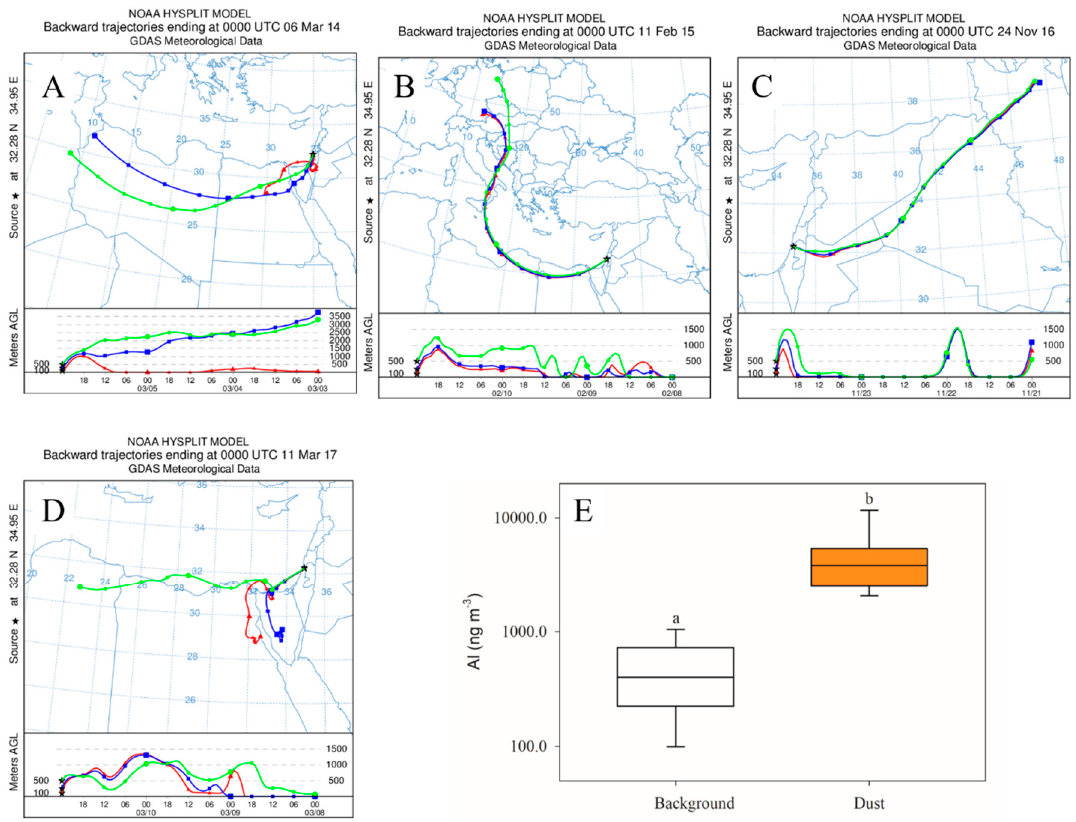
Figure 1. Back-trajectory analyses showing the main dust sources that arrived to the southeastern Mediterranean Sea (SEMS) from 2013 to 2017: ( A ) Sahara Desert, ( B ) Eastern Europe, ( C ) Iraq/Syria, and ( D ) the Middle East; and ( E ) Al concentration measured during non-storm “typical” days (white, median Al = 381 ng m − 3 , n = 89) and during dust storm events (orange, median Al = 3844 ng m − 3 , n = 29) using a high-volume sampler. Trajectory analyses were done for 100 m (red), 500 m (green), and 1000 m (blue) altitude levels. Box-whisker plots show interquartile range (25th to 75th percentile) of the dataset. Horizontal lines within the boxes represent median value. Letters above box-plots represent significant differences ( t -test, p < 0.05) for mean values between background and dust measurements.